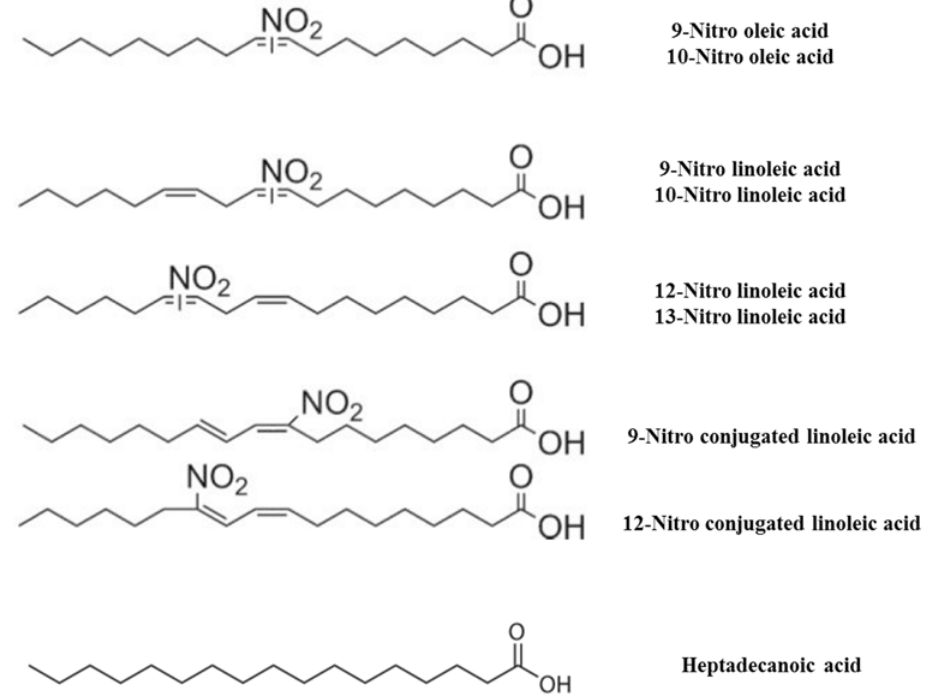
Figure 1. Structures of nitro oleic, nitro linoleic and nitro-conjugated linoleic acid with their positional isomers and structural analog heptadecanoic acid, which was used as an internal standard. Adapted with permission from Ref. [4], 2011, copyright Schopfer, F.J.